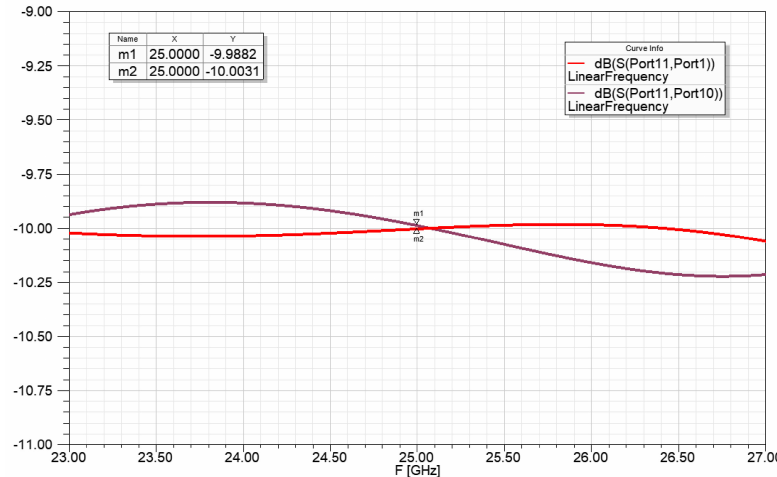
Figure 15. Power ratio for the radiators of the power division network for 1 to 4:2:4 power ratio, with ideal transmission